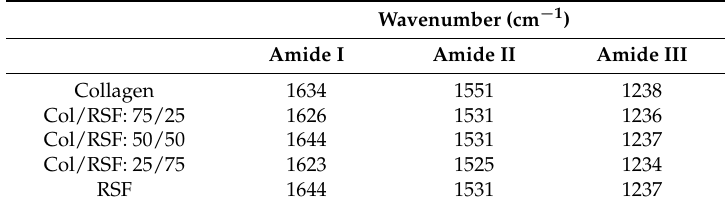
Table 5. The FTIR band assignments of collagen/RSF blends.